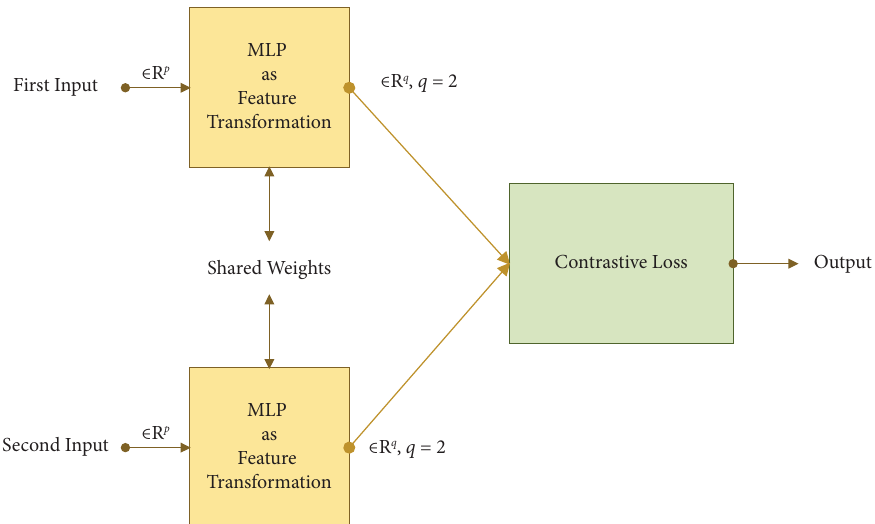
Figure 7: Siamese network with contrastive loss function.